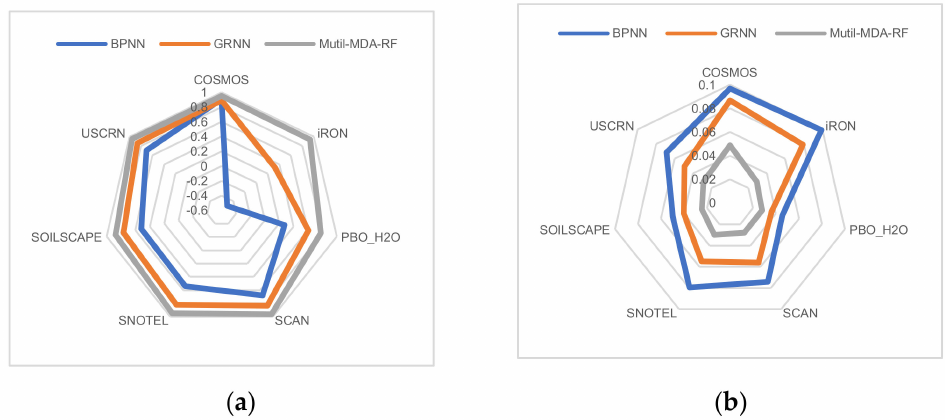
Figure 16. Radar plots for ( a ) R and ( b ) ubRMSE of three models at different